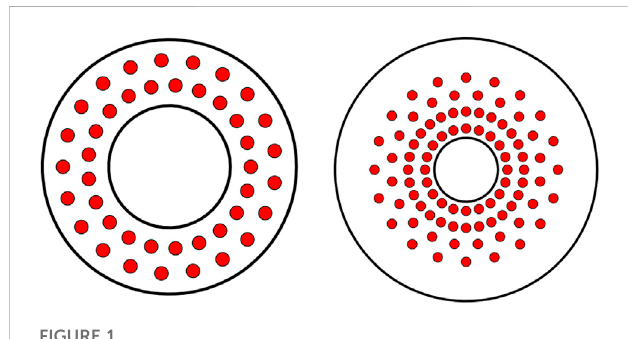
FIGURE 1 Schematic diagram of AWCC and NMC layout